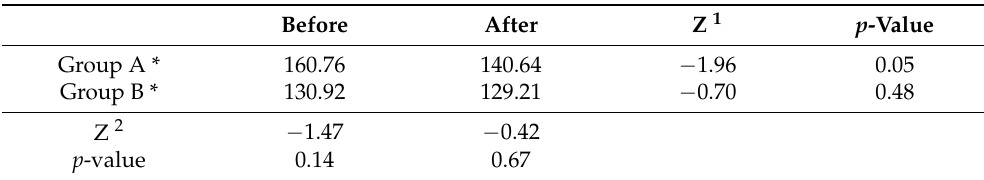
Table 5. Statistical comparison of time taken for information recognition between and within group before and after VCDA. Before After Z 1 p -Value Group A *